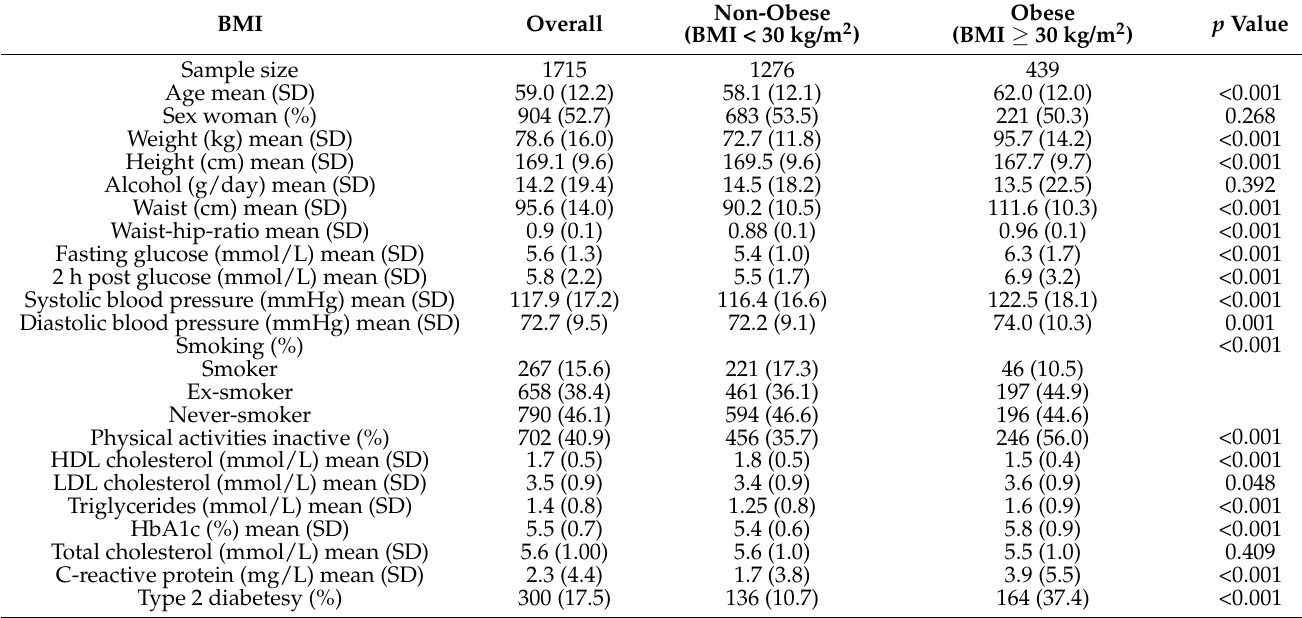
Table 1. Characteristics of the KORA FF4 participants based on their BMI. Mean and standard deviation are provided for quantitative variables. Count and percentage are provided for categorical variables. The significant difference of population characteristics between the individuals with obesity and the normal participants was calculated. Categorical variables were calculated via the chi square test. Student’s t test was used for continuous variables. Abbreviations: HbA1C, glycated hemoglobin; HDL, high-density lipoprotein; LDL, low-density lipoprotein.